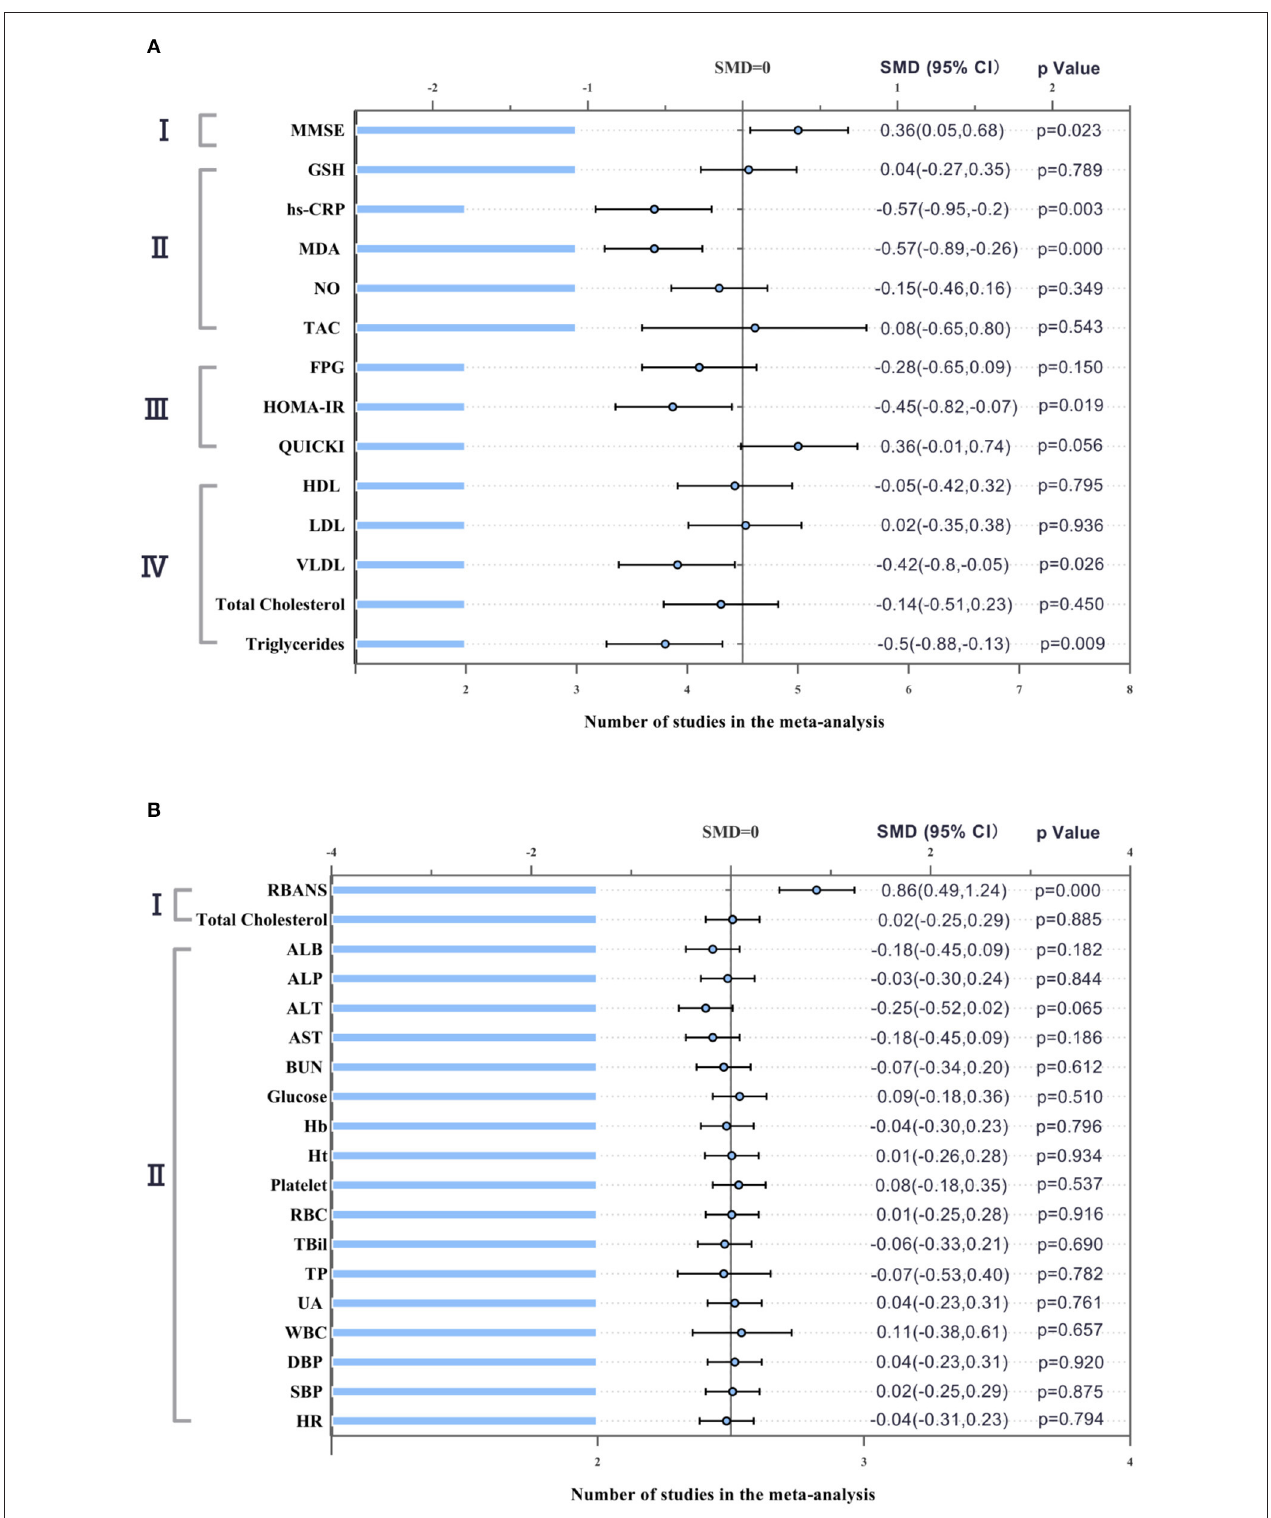
FIGURE 3 | Forest plot showing the effects in the probiotics group versus the control group on cognitive function and biochemical indicators. (A) Meta-analysis of the effects of probiotics on patients with AD. I. MMSE (Mini-Mental State Examination); II. Biomarkers of inflammation and oxidative stress. GSH (glutathione); hs-CRP (hypersensitive-CRP); MDA (Malondialdehyde); NO (Nitric Oxide); TAC (tricarboxylic acid cycle); III. Glucose related indicators. FPG (fasting plasma glucose);